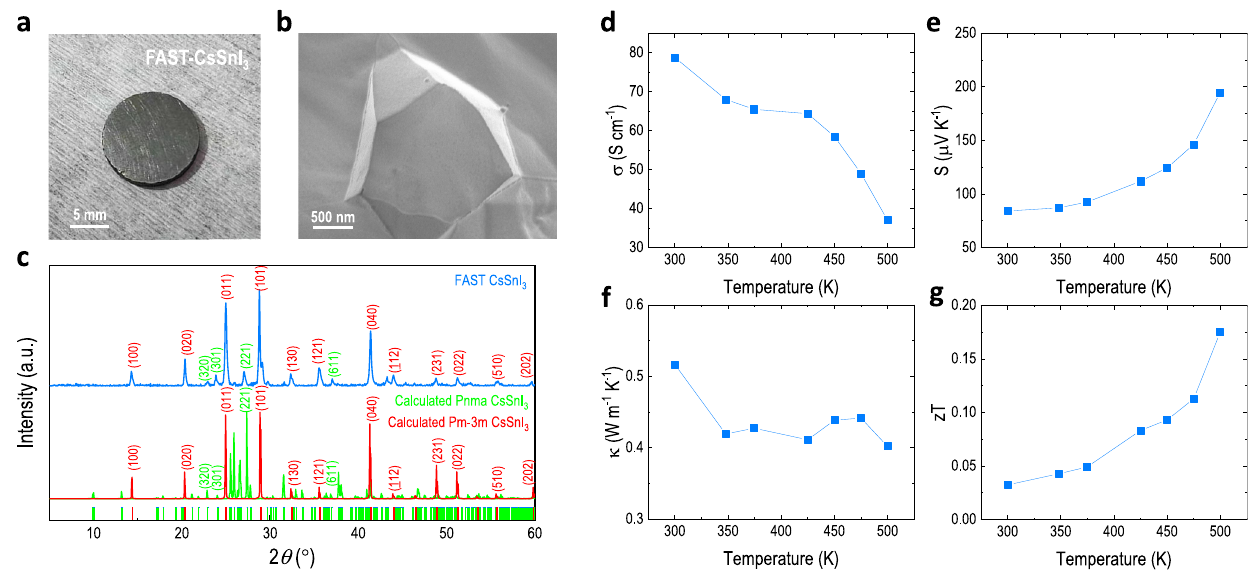
Fig.7|FAST-CsSnI 3 withrecordzTamonghalideperovskites.a Picture, b cross- sectional SEM, and c XRD spectra (with a comparison of calculated cubic and orthorhombic phases) of FAST-CsSnI 3 pellet. Temperature-dependent d electrical